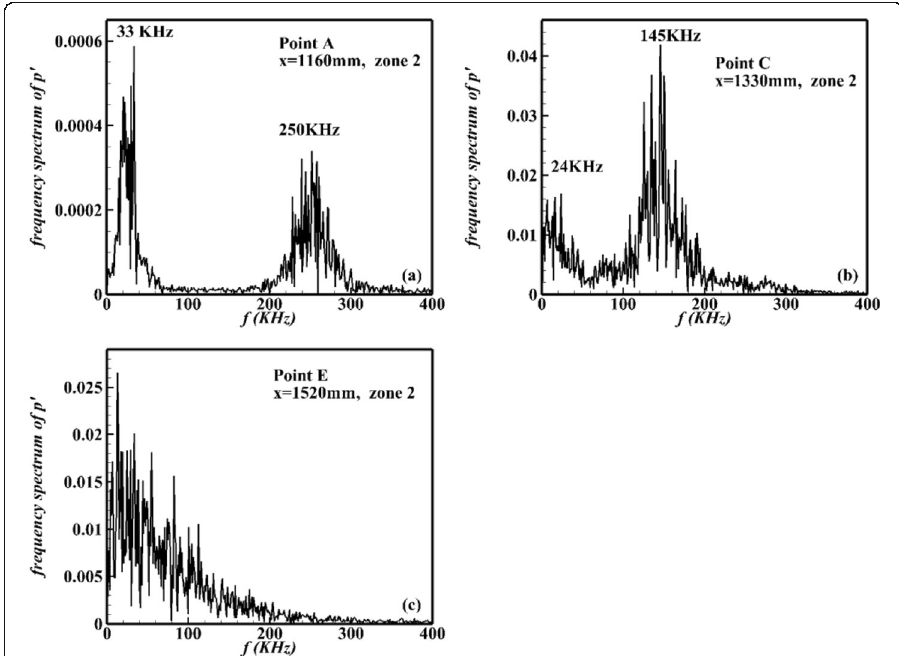
Fig. 18 Spectra of pressure fluctuations of zone 2; ( a ) x = 1160 mm, ( b ) x = 1330 mm, ( c ) x = 1450 mm